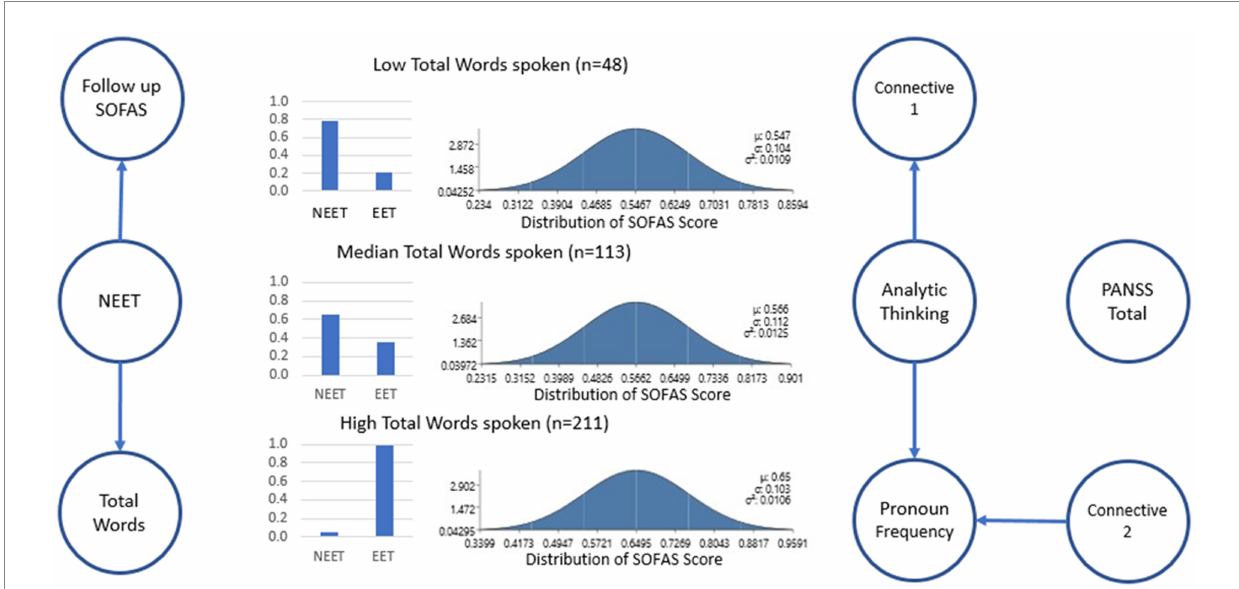
FIGURE 1 Bayes network that resulted from the application of the PC algorithm. Only the total number of words directly relates to NEET and indirectly relates to SOFAS. Furthermore, whereas the PANSS score was independent of all the other variables, the remaining predictors (Analytic thinking, Total connectives, acausal connectives, and pronoun use) show conditional dependencies among themselves. Binarized NEET/EET Probability and distribution of predicted SOFAS scores are shown based on Low, Median, and High number of words spoken. We have modified the figure to better explain the structure of the Bayes network by indicating that “circles represent variables of interest.” Arrows (i.e., directed edges) connecting circles indicate a causal influence from the ancestor to the descendent—parameterized in a conditional probability distribution. For example, a line showing follow-up SOFAS score is dependent upon NEET status. Note that there are no edges between “total PANSS” and the other variables, indicating independence. *SOFAS, Social and Occupational Functioning Assessment Scale; Connectives 1, All connectives use; Connectives 2, Acausal Connectives use; PANSS, Positive and Negative Syndrome Scale 8-Item Version; NEET, Not in Employment, Education or Training; EET, Engaged in employment education, or